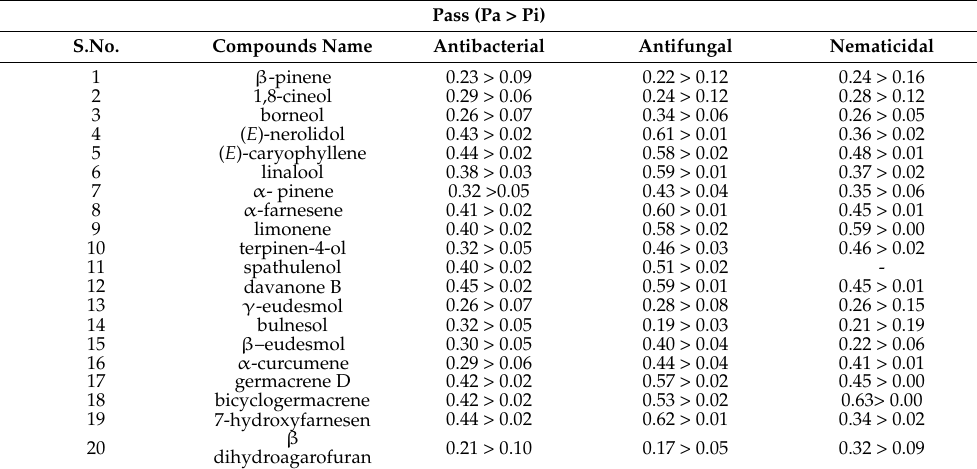
Table 16. In silico PASS prediction for antibacterial, antifungal, and nematicidal activity of selected phytochemical compounds from HCCAO and